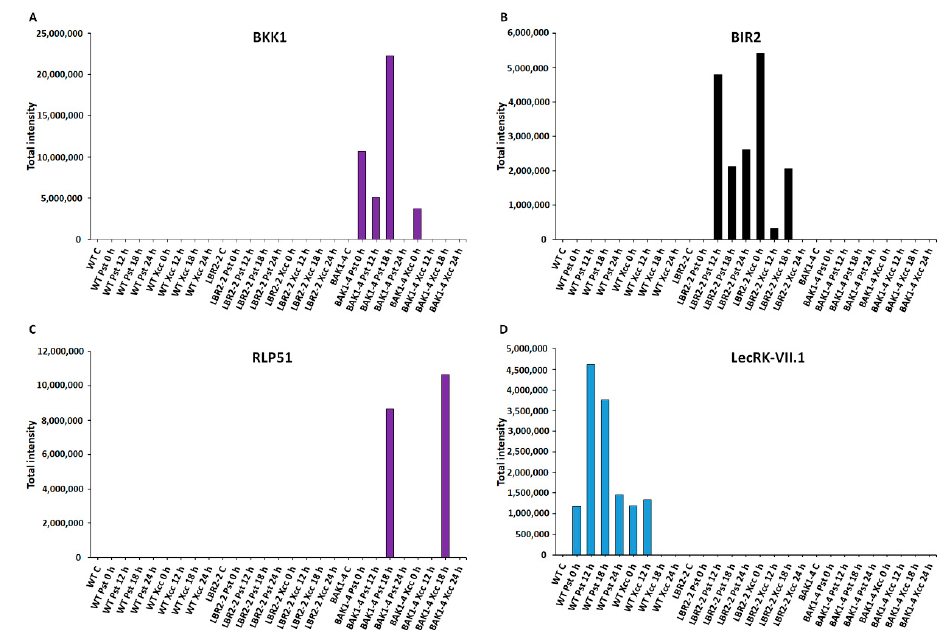
Figure 3. Comparative analyses of total peak intensities of PM-associated proteins involved in perception and signalling . Total peak intensity of selected significant PM-associated proteins for ( A ) BAK1-like 1 (BKK1), ( B ) BAK1-interacting receptor-like kinase 2 (BIR2), ( C ) Receptor-like protein 51 (RLP51) and ( D ) L-type lectin-domain containing receptor kinase VII.1 (LecRK-VII.1). Data from the WT are indicated in blue, the lbr2-2 mutant in black and the bak1-4 mutant in purple, with time periods of 0–24 h as indicated.